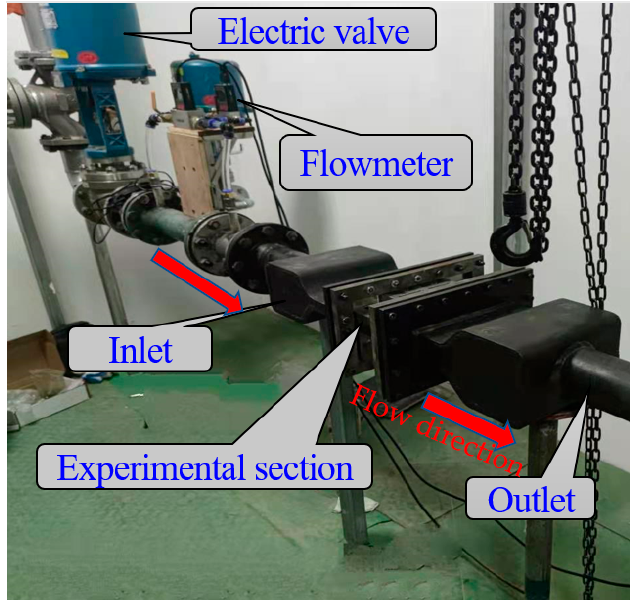
Figure 3. Structure diagram of the experimental bench.